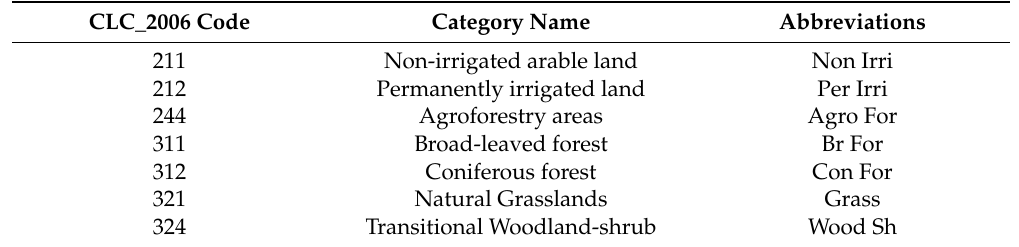
Natural Grasslands Grass Transitional Woodland-shrub Wood